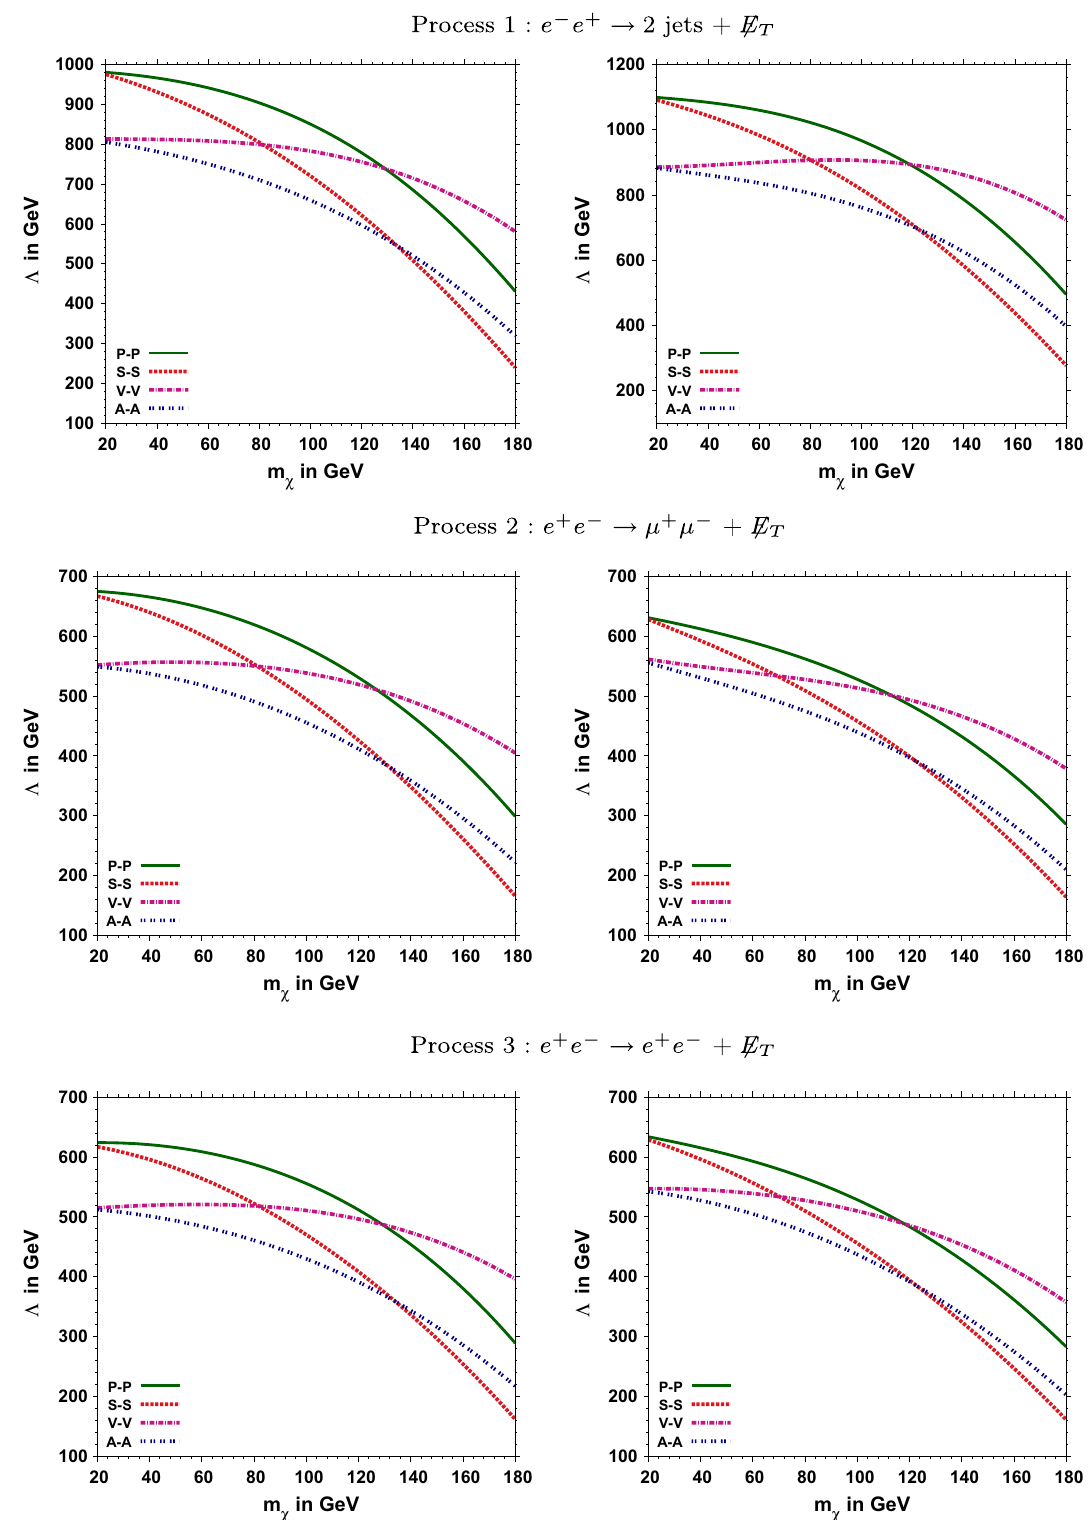
Fig. 7 99% confidence level contours in the m χ and Λ plane from the χ 2 analyses of the respective final visible states at the collider parameter choice given in the first and the second column of Table 1. The contours at the left correspond to the unpolarised beam